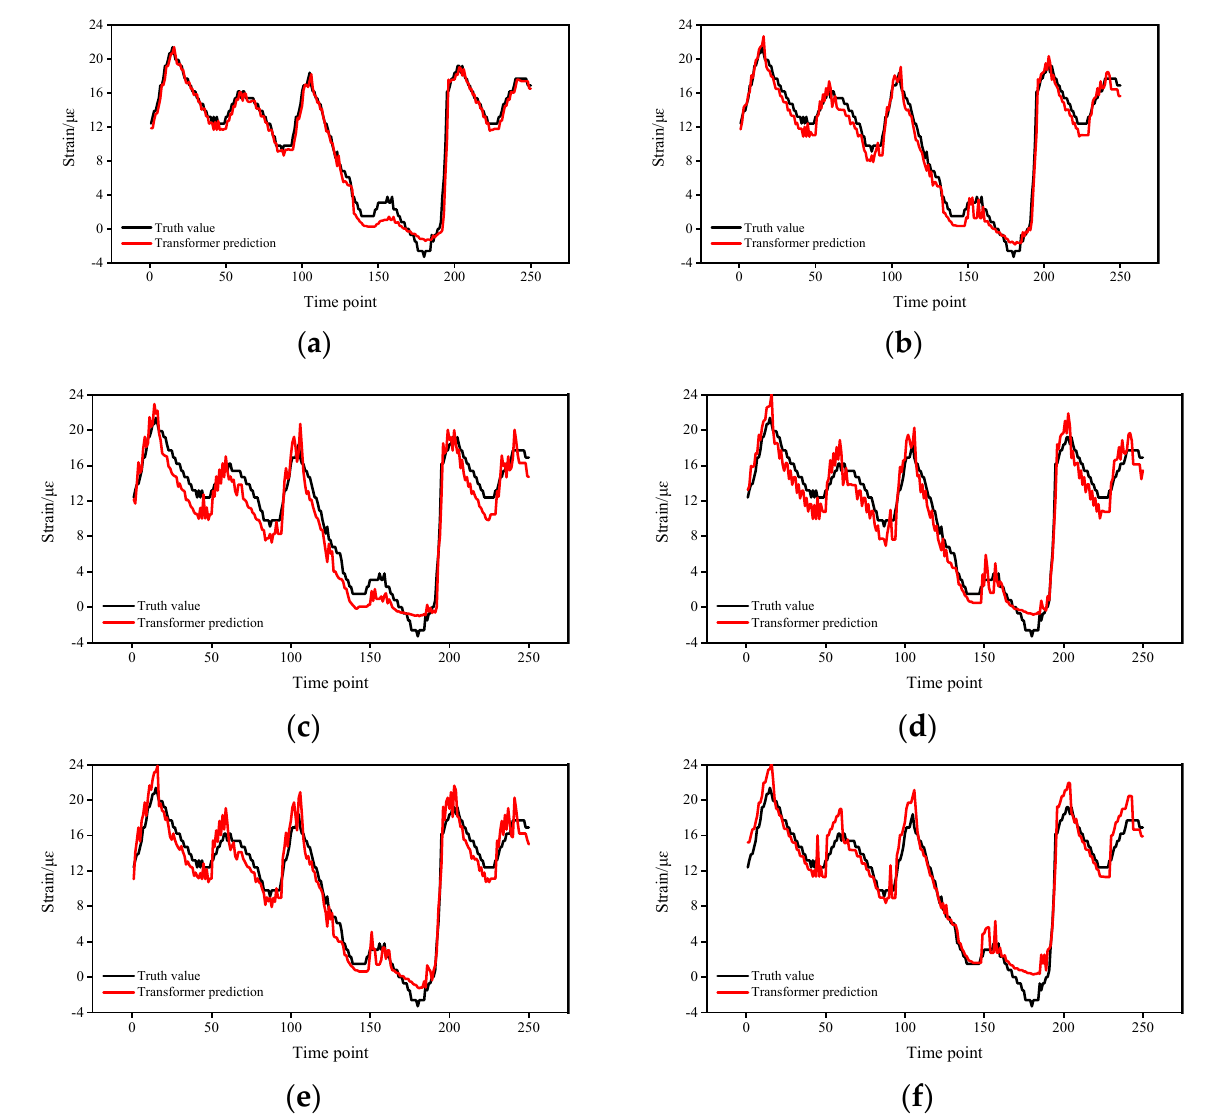
Figure 6. Prediction results for different numbers of prediction points: ( a ) Two-point prediction. ( b )